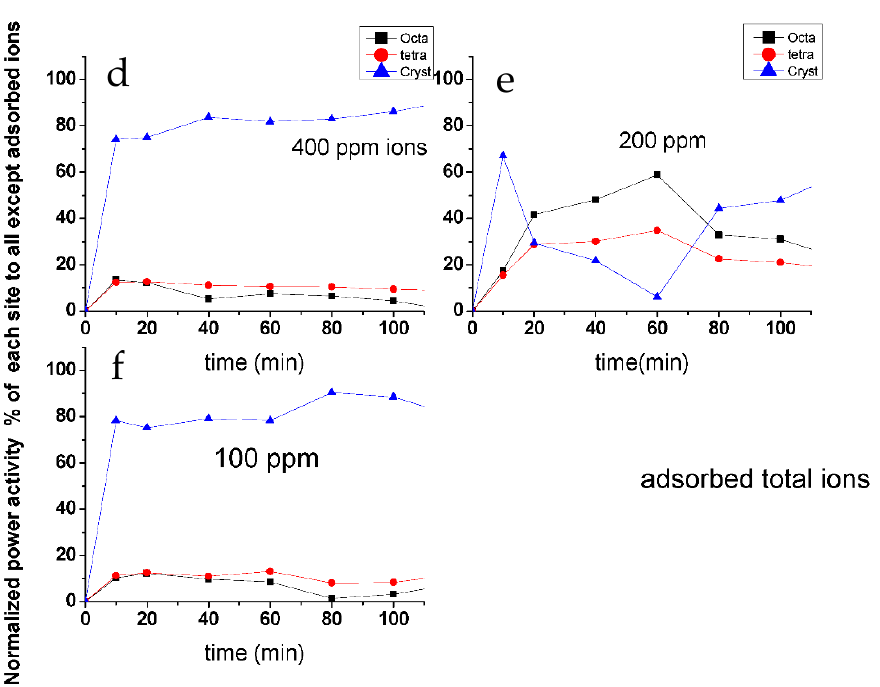
Figure 11. The effect of adsorbed ions and remaining ions on the power activity of each site: ( a ) 400 ppm remained; ( b ) 200 ppm remained; ( c ) 100 ppm remained; ( d ) 400 ppm adsorbed; ( e ) 200 ppm adsorbed; ( f ) 100 ppm adsorbed.